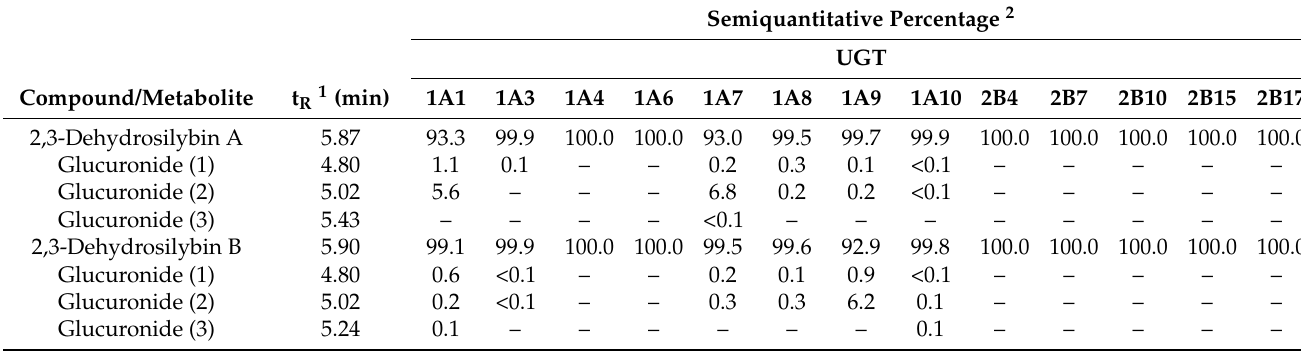
Figure 2. Biotransformation of 2,3-dehydrosilybin A and B by human hepatocytes. Human hepatocytes were incubated for 1 h with 50 µ M 2,3-dehydrosilybin A (panel a ) or 2,3-dehydrosilybn B (panel b ), collected by centrifugation and analyzed by ultra-high-performance liquid chromatography coupled with tandem mass spectrometry (UHPLC-MS). The signal intensity in chromatograms was adjusted to the same value before using the zoom tool. Table 2. Glucuronidation of 2,3-dehydrosilybin A and 2,3-dehydrosilybin B by human